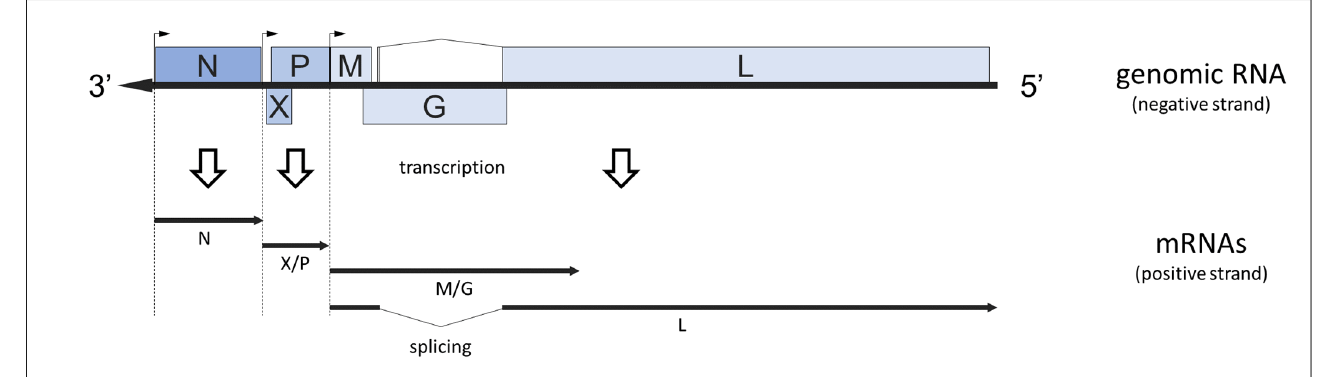
Figure 2. Organization of the Orthobornavirus genome. The negative-sense genome (presented in 3 ′ - to-5 ′ orientation) of orthobornaviruses contains open-reading frames (ORF) encoding six major proteins: N = nucleoprotein, X = accessory protein X, P = phosphoprotein, M = matrix protein, G = glycoprotein, L = large RNA-dependent RNA polymerase. The structure is based on the BoDV-1 reference genome (GenBank accession number NC_028100). ORFs shown in identical shadings of blue are translated from the same bi- or polycistronic mRNA. Major mRNA variants are shown as black arrows in 5 ′ -to-3 ′ orientation below the genome.